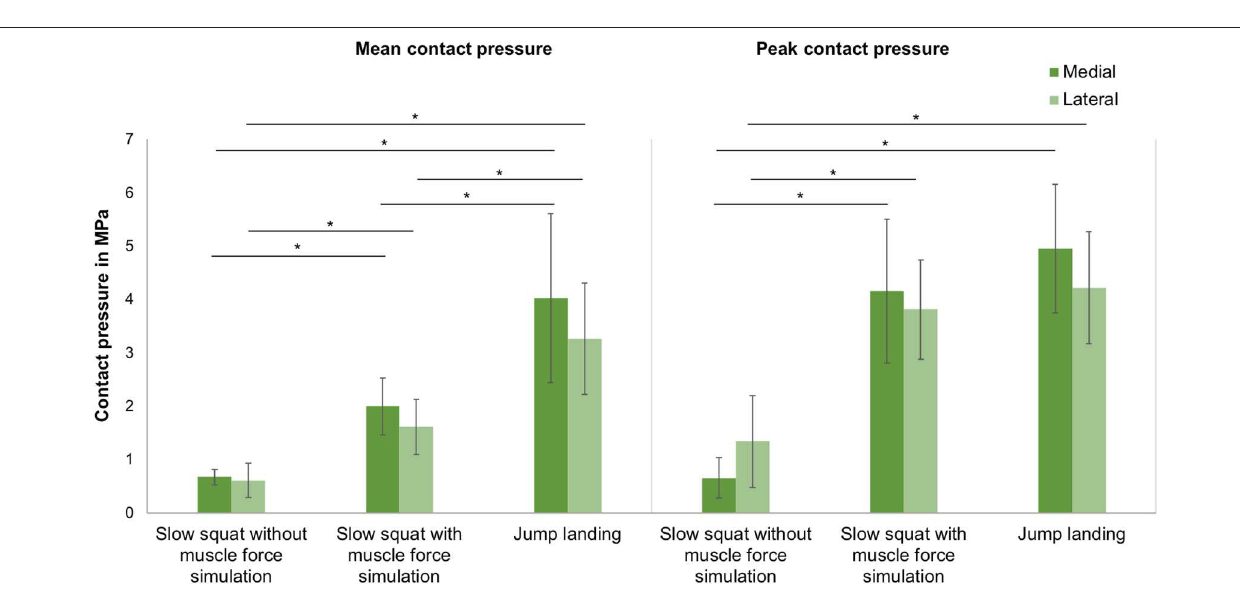
FIGURE 6 | Mean and peak contact pressure (mean ± SD) in the medial and lateral compartments for slow squat without muscle force simulation, slow squat with muscle force simulation and a jump landing exercise. * p ≤ 0.05 ( n = 9). ( p > 0.187) when comparing the slow squat with muscle force simulation and the jump landing with muscle force